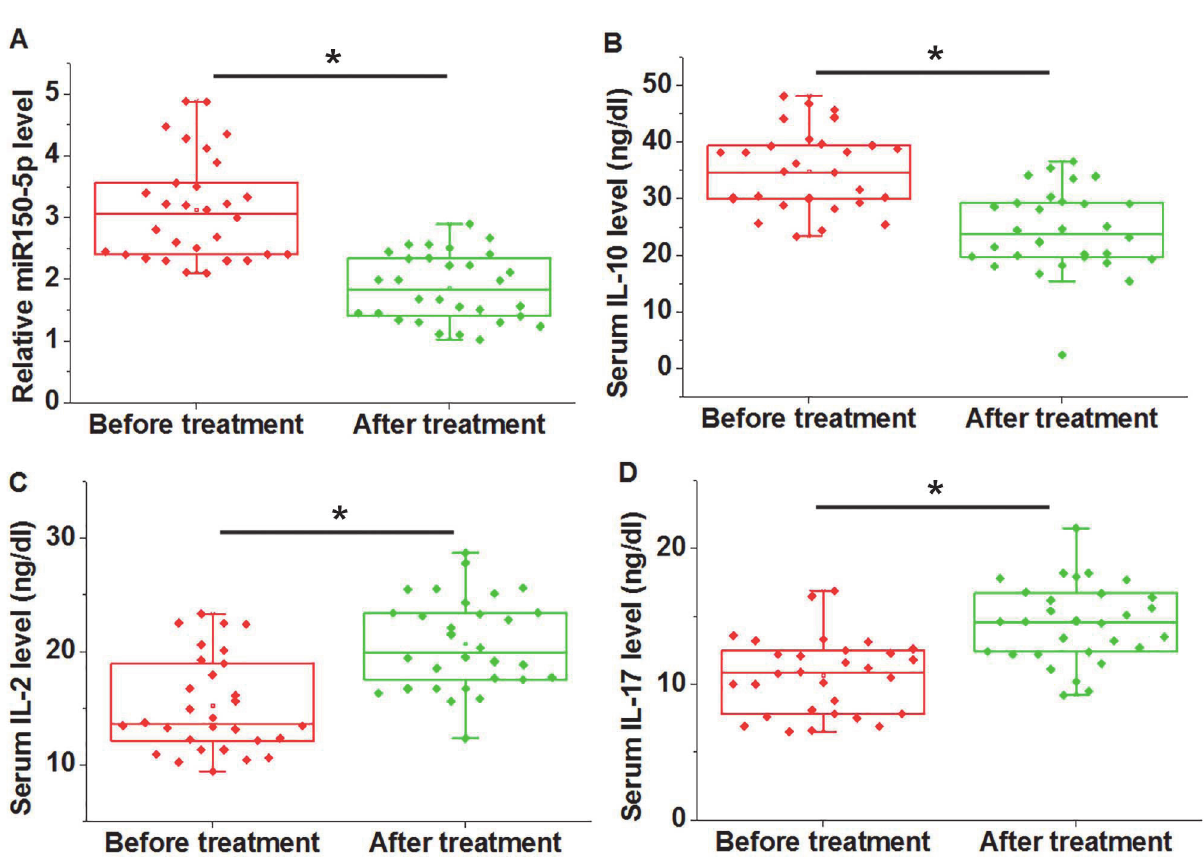
Fig. 4. Medical treatment led to decreased serum levels of miR150-5p and IL-10 as well as increased serum levels of IL-2 and IL-17. After treatment, ELISA results revealed decreased serum levels of miR150-5p (A) and IL-10 (B) as well as increased serum levels of IL-2 (C) and IL-17 (D) in patients with generalized myasthenia gravis (*, P